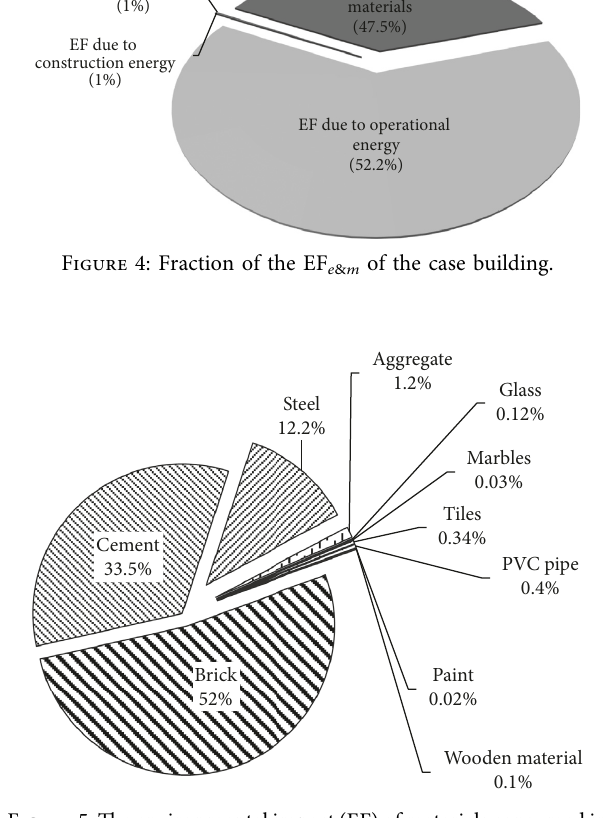
Figure 5: The environmental impact (EF) of materials consumed in the case building.